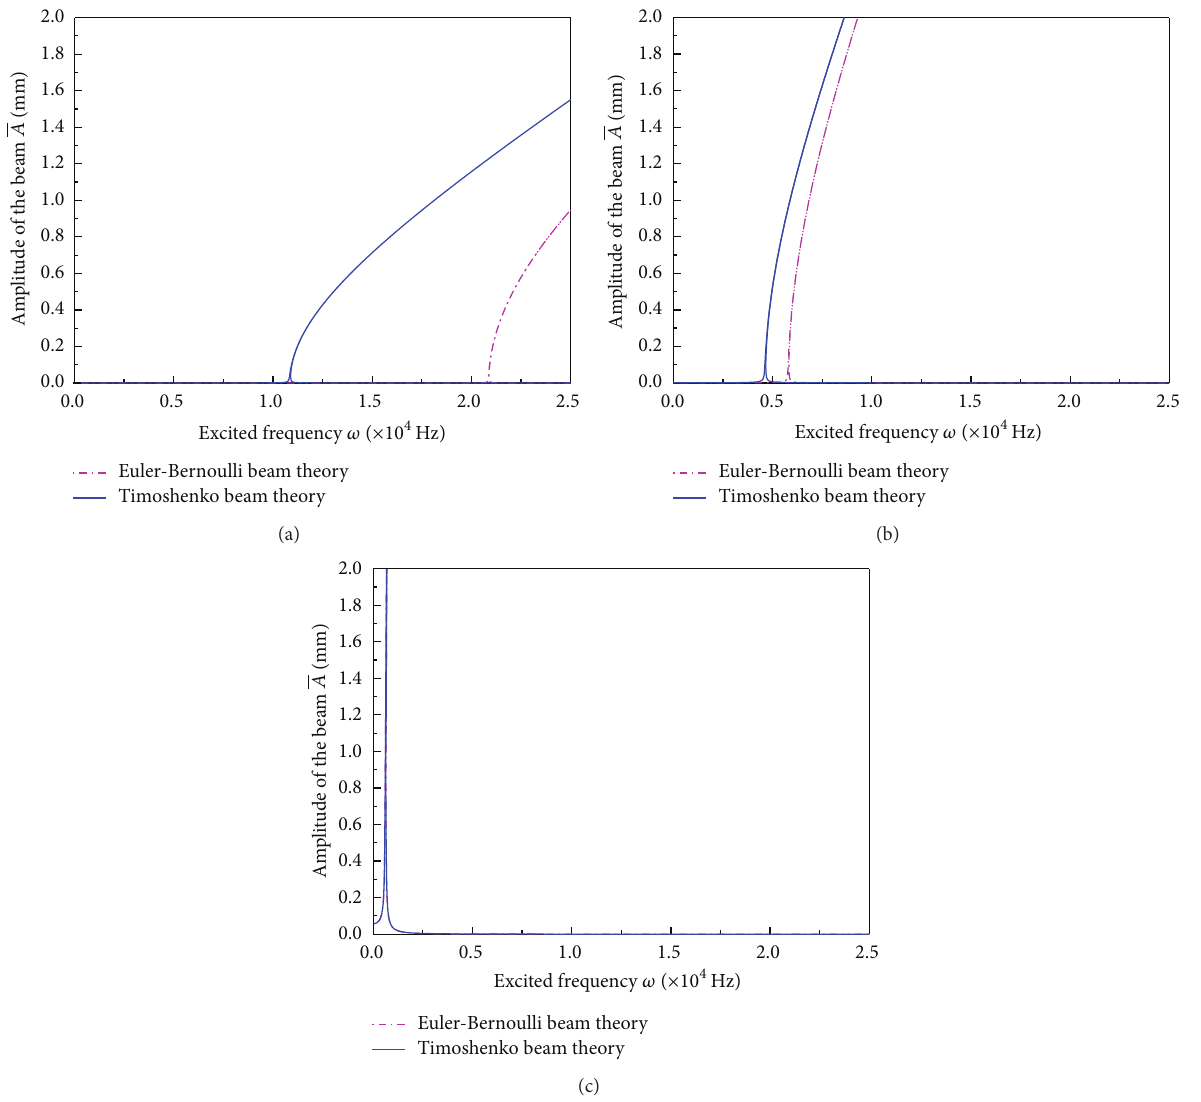
Figure 4: Frequency responses of the composite beams in the phase transformation state from martensite to austenite under the excitations ( 𝑇 = 50 ∘ C, 𝜀 0 = 0.03 , 𝑉 𝑠 = 0.005 , and 𝑞 0 = 10 N): (a) 𝐿/ℎ = 5 ; (b) 𝐿/ℎ = 10 ; and (c) 𝐿/ℎ = 50 . Table 4: The nonlinear natural frequency for different values of 𝑉 𝑠 with various 𝐴 0 /ℎ ( 𝐿/ℎ = 6 , 𝑇 = 60 ∘ C, and 𝜀 0 = 0.03 ). 𝐴 /ℎ Beam theory 𝑉 0